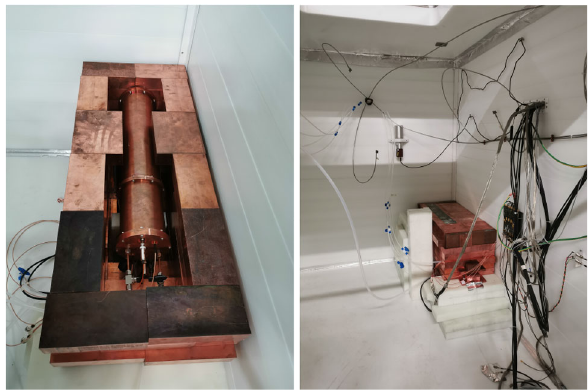
Fig. 1 Left: PoP-dry copper shielding opened inside the SABRE PoP passive shielding at LNGS. The detector module containing the NaI-33 crystal is also visible in this picture. Right: PoP-dry copper + PE slabs shielding closed inside the SABRE PoP passive shielding at